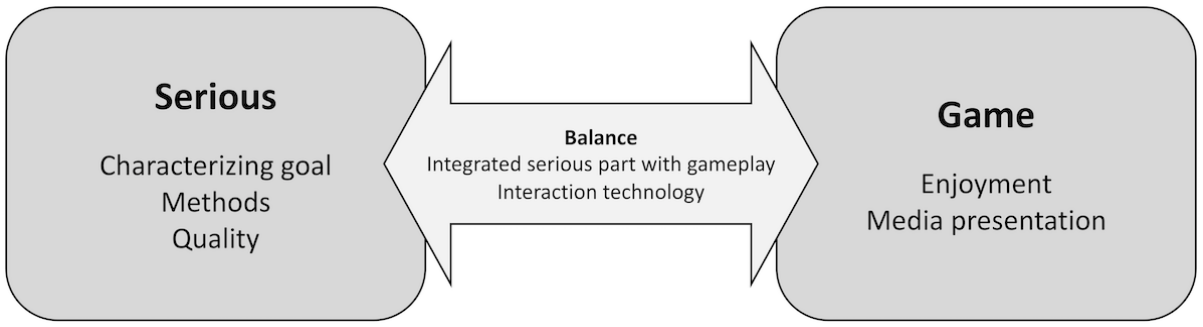
Figure 1. Quality criteria for the serious part and game part, as well as the balance between them.